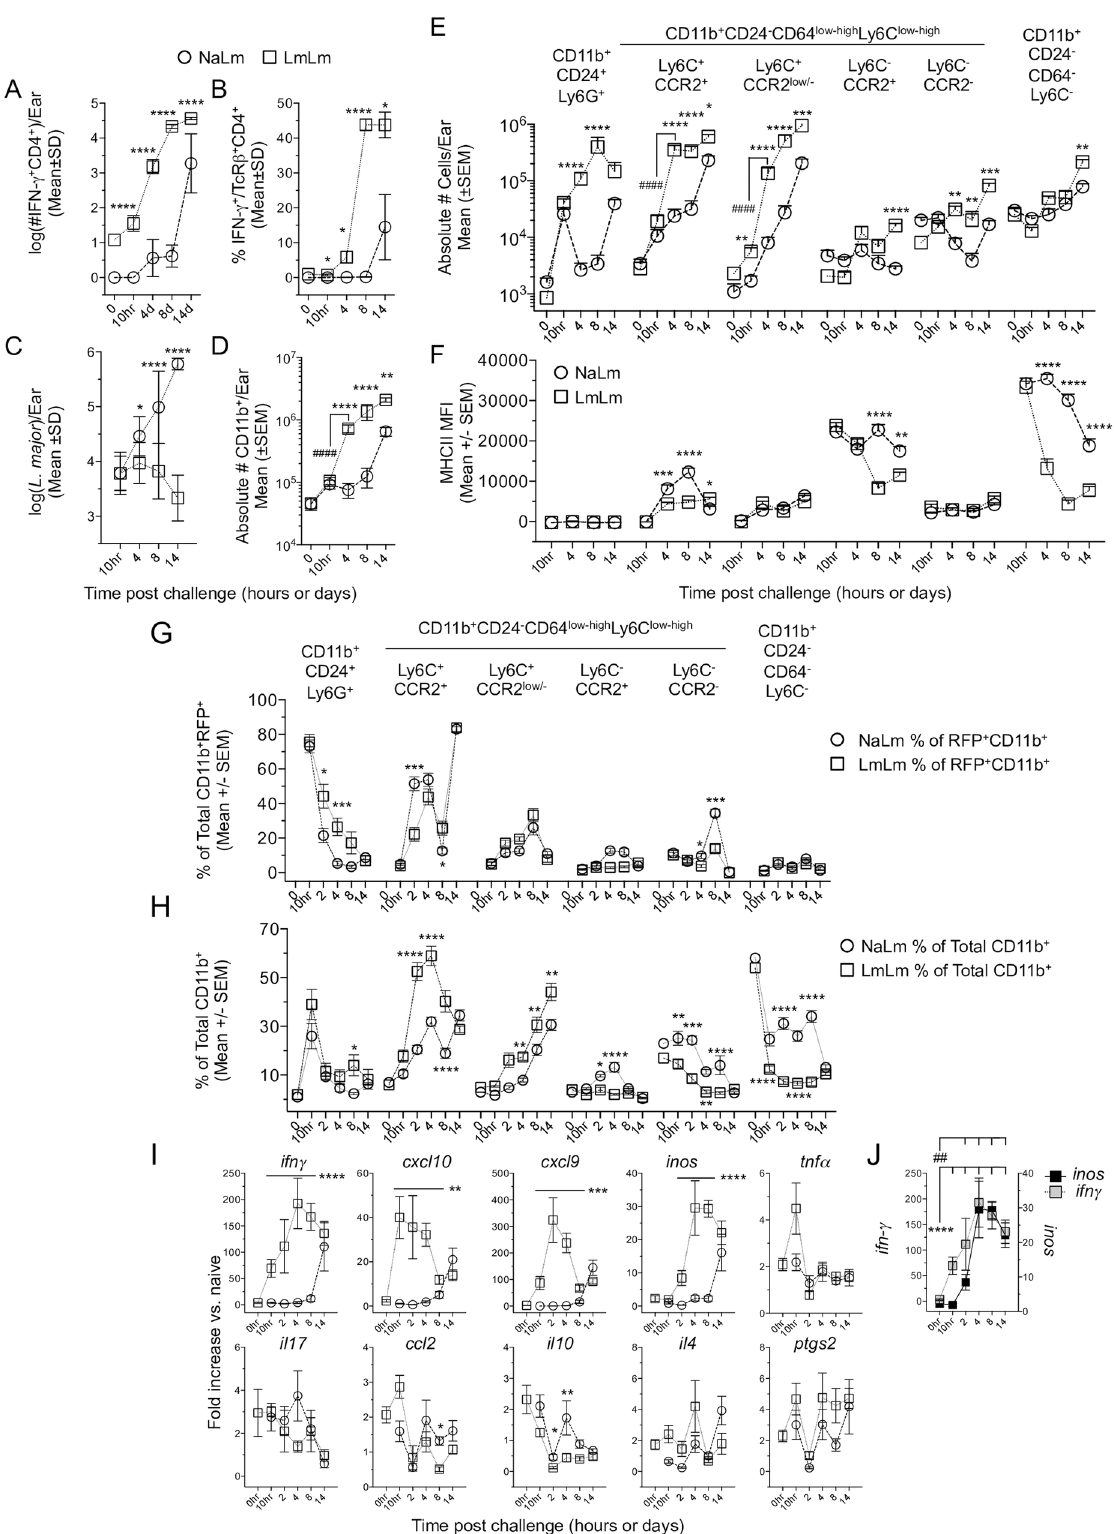
Fig 3. Disparate inflammatory monocyte responses at sites of primary and secondary infection. Na ï vewild type B6 mice (NaLm) or mice with a healedbut persistent primary infection(LmLm) were challenged in the ear with 2x10 5 L . major (A-F) or L